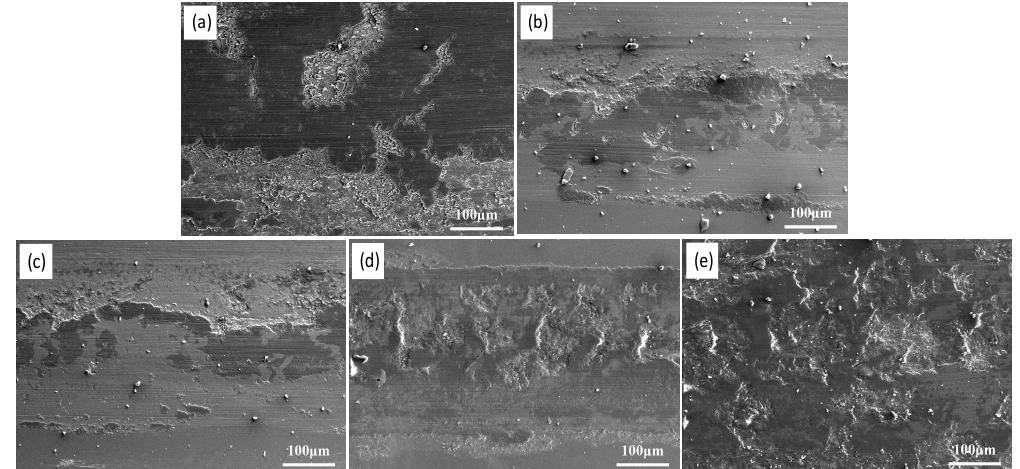
Figure 9. SEM micrographs of worn surface of the laser melting deposited Fe-based alloy gradient